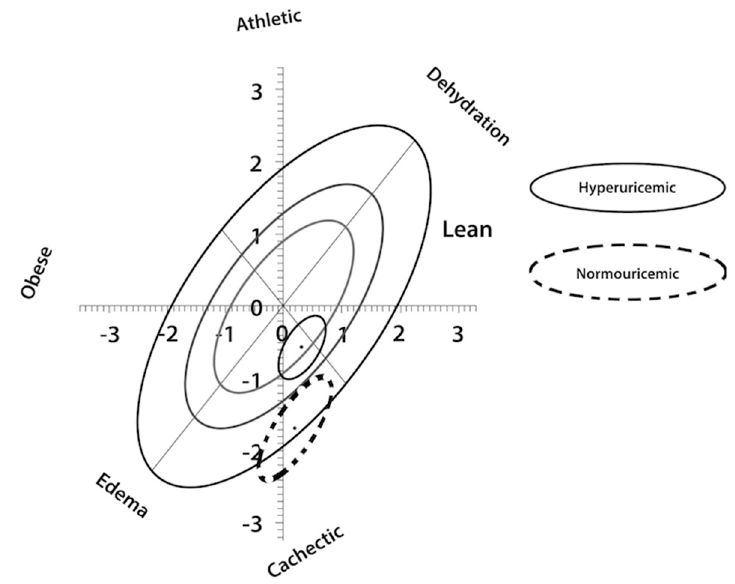
Figure 1. Z Score of normouricemic and hyperuricemic patients by Bioelectrical Impedance Vector Analysis (BIVA). Continuous line represent hyperuricemic subjects and dotted line represent normouricemic subjects.